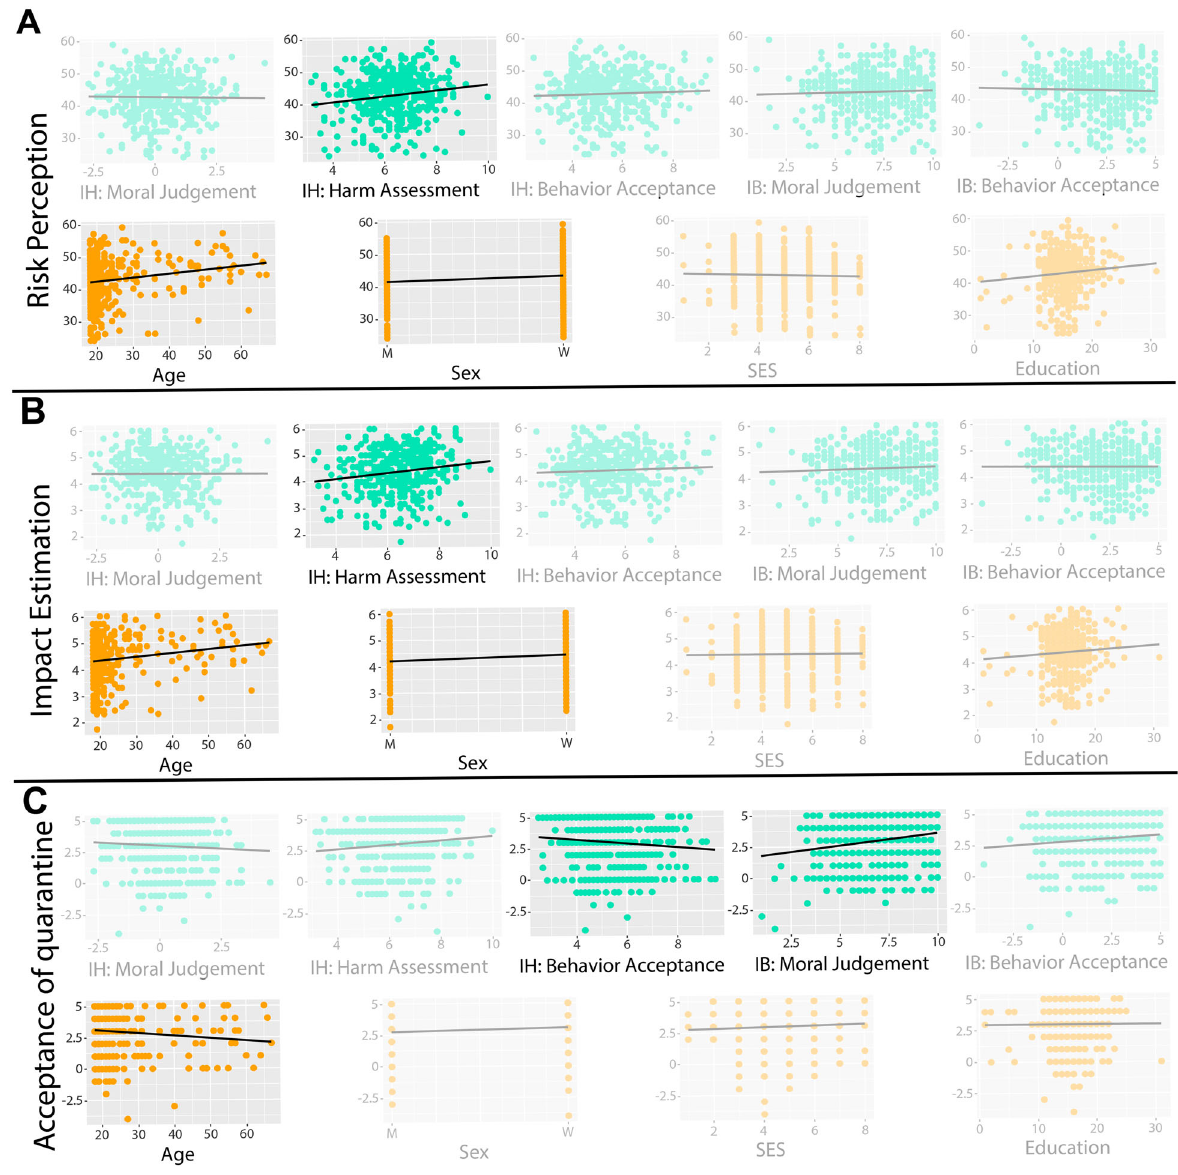
Fig. 2 Multiple regression analyses using moral judgment measures as predictors. A Regression analysis using risk perception as the dependent variable. This variable was explained by harm assessment in IH, age, and sex. B Regression analysis using impact estimation as the dependent variable. This variable was predicted by harm assessment in IH, age, and sex. C Regression analysis using the acceptance of quarantine as the dependent variable. This variable was predicted by increased acceptance of IB, reduced acceptance of IH, and age. The non-signi fi cant variables were shaded across panels. IH instrumental harm, IB impartial bene fi cence, SES socioeconomic